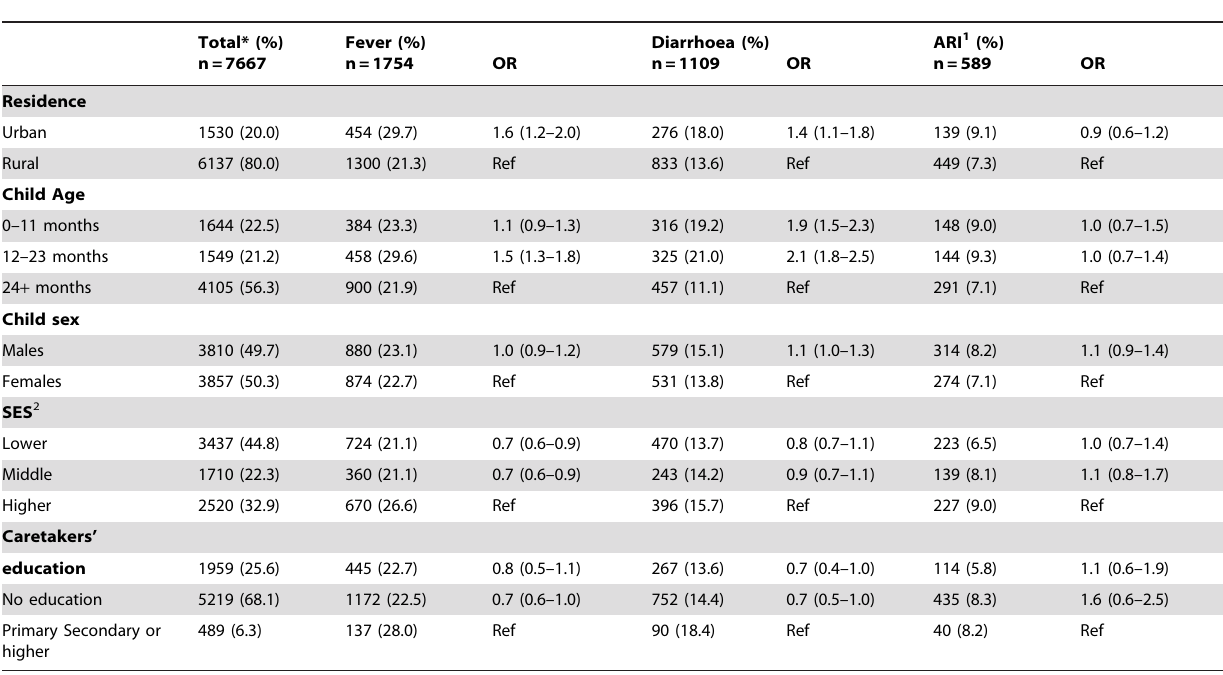
Table 1. Background factors as determinants of occurrence of common illnesses in children under the age of five in Tanzania,